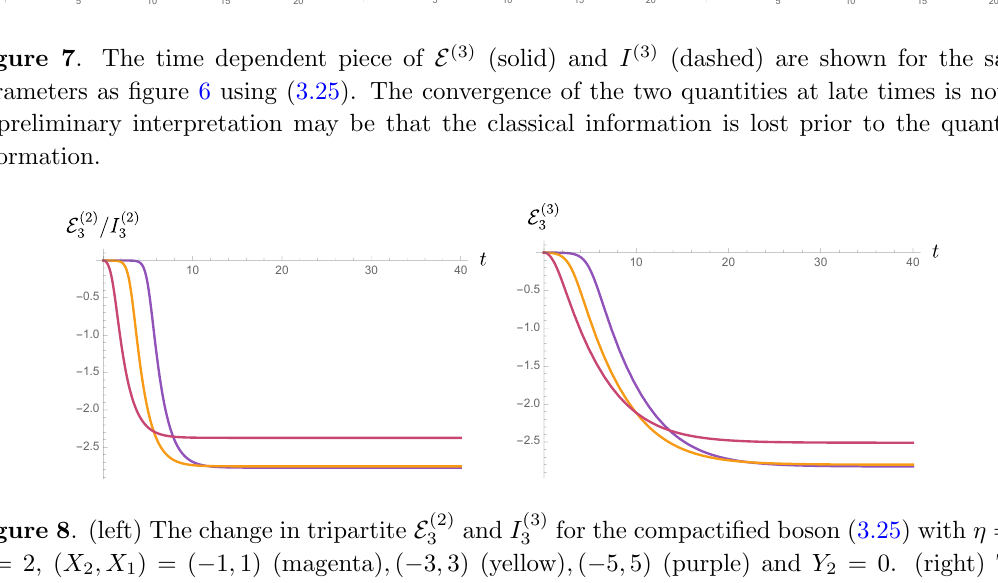
Figure 8 . (left) The change in tripartite E (2) (cid:12) = 2, ( X 2 ; X 1 ) = ( (cid:0) 1 ; 1) (magenta) ; ( (cid:0) 3 ; 3) (yellow) ; ( (cid:0) 5 ; 5) (purple) and Y 2 = 0. (right) The third tripartite R(cid:19)enyi negativity for the same intervals and (cid:17) = 3, (cid:12) =